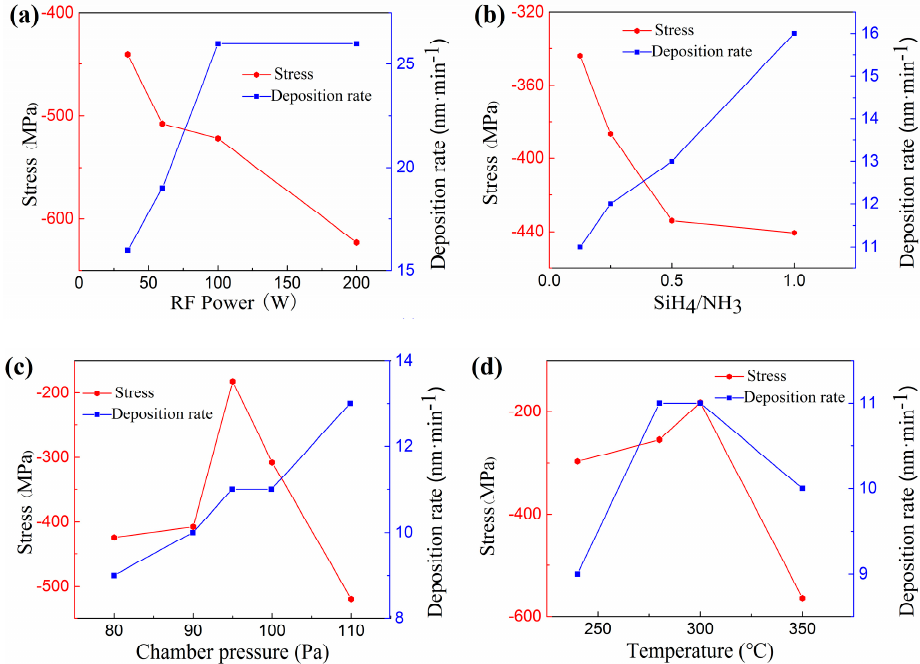
Figure 5. Influence of some of the key deposition parameters of the process: ( a ) RF power; ( b ) SiH4–NH3 flow ratio; ( c ) Chamber pressure; ( d ) Temperature, with the intrinsic stress level and deposition rate. The equipment used here was PECVD (PD-220, SAMCO).